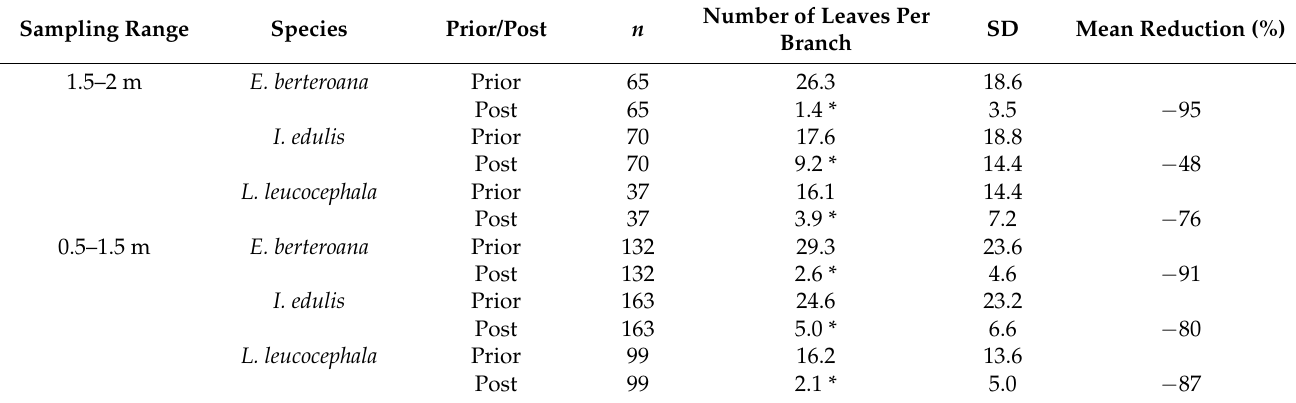
and 80%, respectively). Table 3. Mean leaf count (number of leaves per branch), standard deviation (SD) and mean reduction (%) prior to and post cattle browsing trial on individuals ( n ) of potential browse species E. berteroana , I. edulis and L. leucocephala . Significant differences ( p < 0.05) between leaves counted prior to and post browsing are denoted by an asterisk (*). Sampling Range